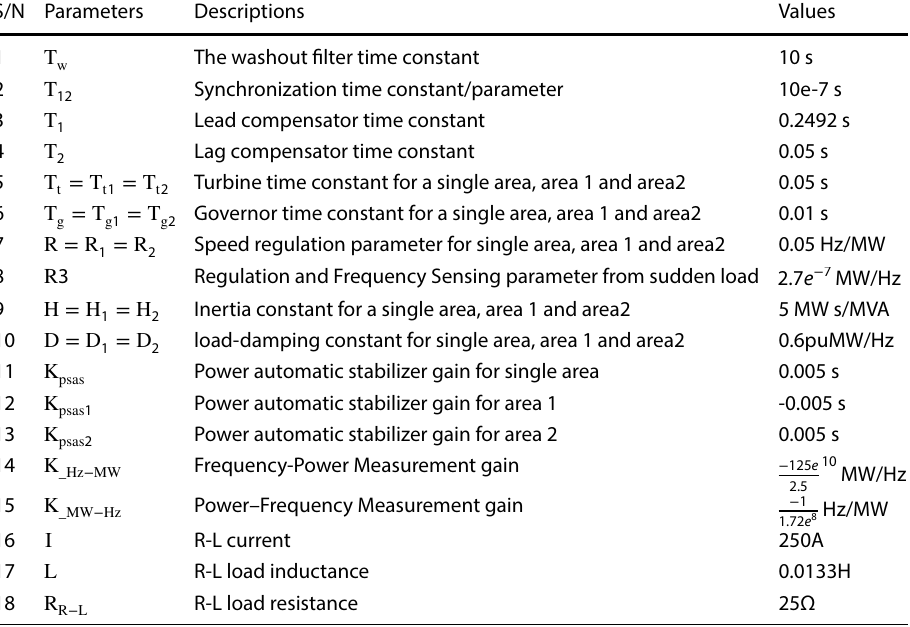
Table 2 Parameters and setting values used in power